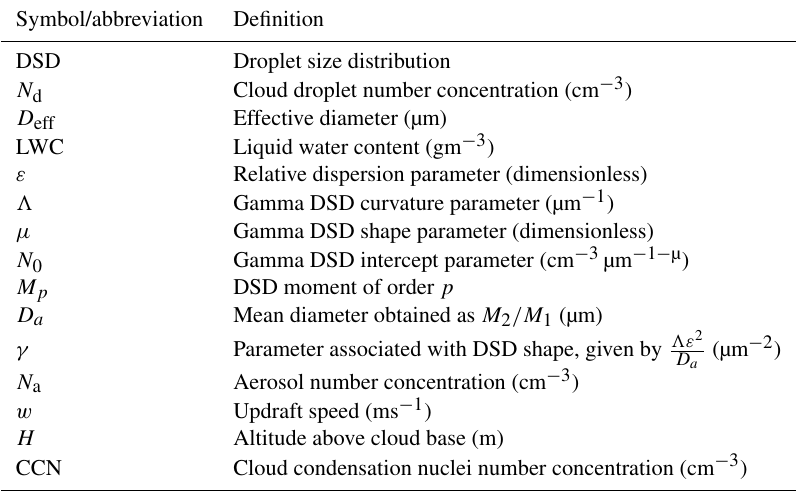
Table 1. Definition of the symbols and abbreviations discussed in this